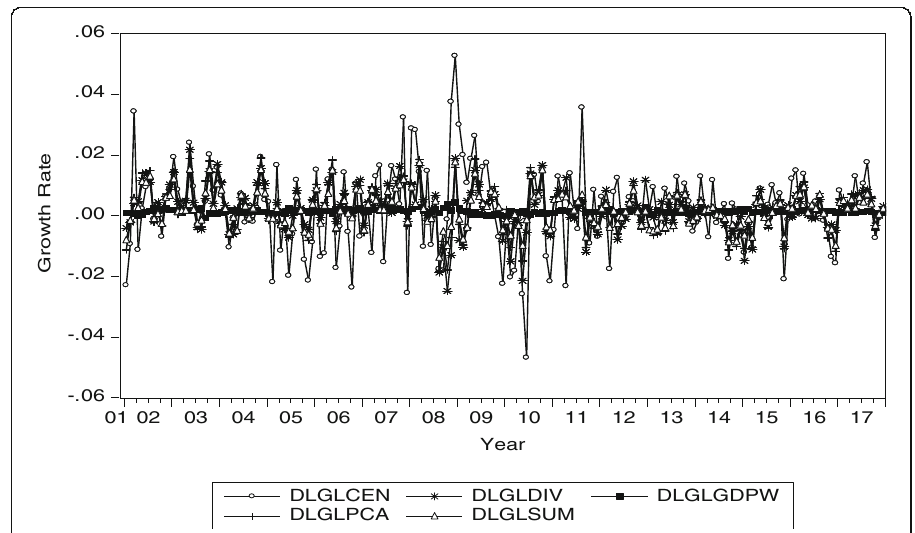
Fig. 6 Monthly Growth Rates of Global Monetary Aggregates. DLGLCEN, DLGLDIV, DLGLGDPW, DLGLPCA and DLGLSUM are log differences of CE, Divisia index, GDP-weighted, PCA-based, and Simple-Sum measures for global liquidity respectively. The numbers 01 through 17 on the horizontal axis represent the years 2001 through 2017